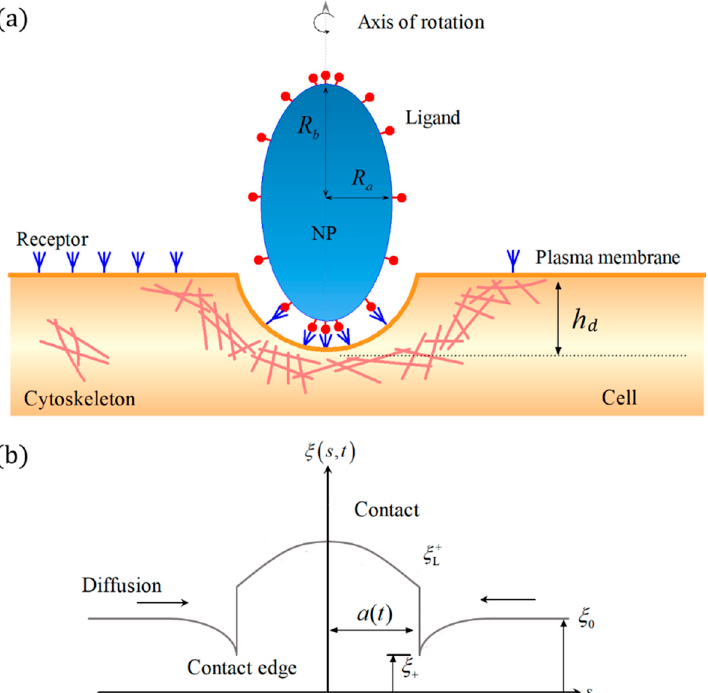
Figure 1. Schematic of the interaction between ellipsoidal NPs with different ligand distributions and cells via cytoskeleton-associated endocytosis. ( a ) Remote mobile receptors diffusing to binding sites to drive cellular uptake. ( b ) Receptor density distribution along the cell membrane.